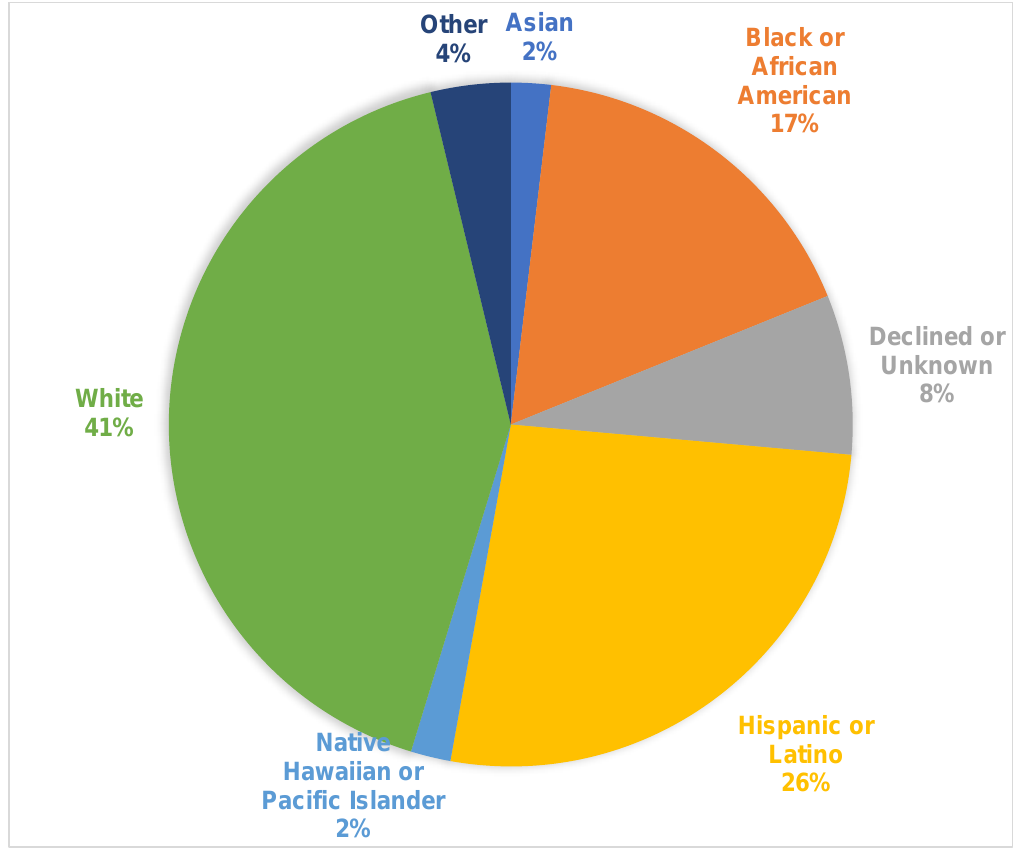
Figure 1. Race/Ethnicity. Table 2. Number of patients with positive and negative diagnostic yield based on presence of patient factors. Comparison within variables performed via Chi-square